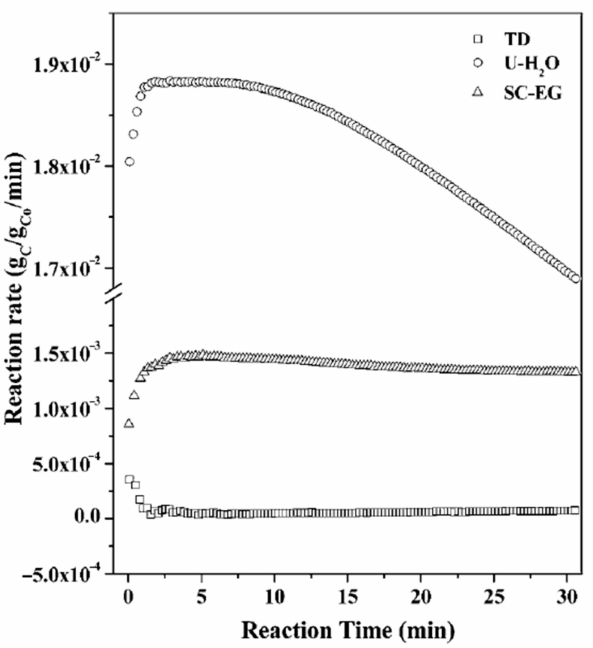
Figure 2. The catalytic activity of the three cobalt catalysts prepared by different methods: precip- itation with urea in an aqueous medium (U-H 2 O), precipitation by using sodium carbonate in an ethylene glycol medium (SC-EG), and by thermal decomposition of cobalt nitrate (TD); reprinted with permission from ref. [37]. Copyright 2008 Royal Society of Chemistry.